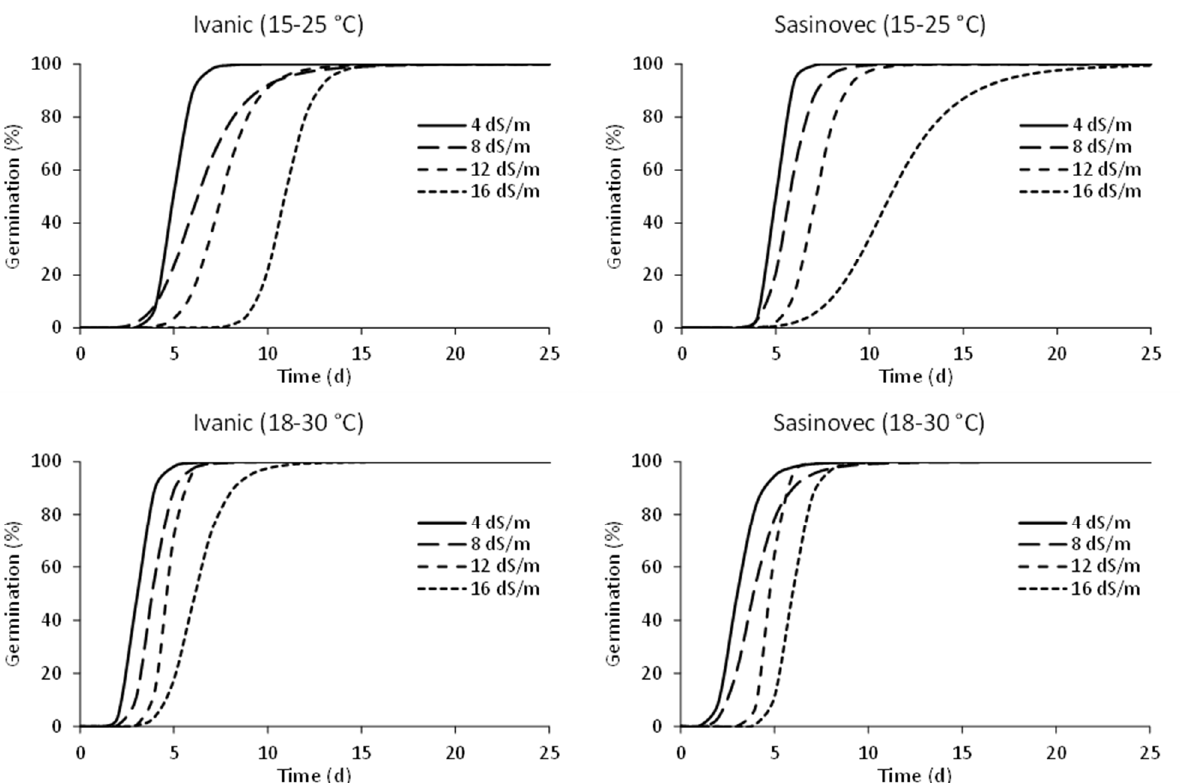
Figure 3. Germination patterns of the two populations of D. stramonium in different temperature ranges and salinity levels. The parameters estimated and the measures of goodness of fit are reported in the Appendix A (Table A1).